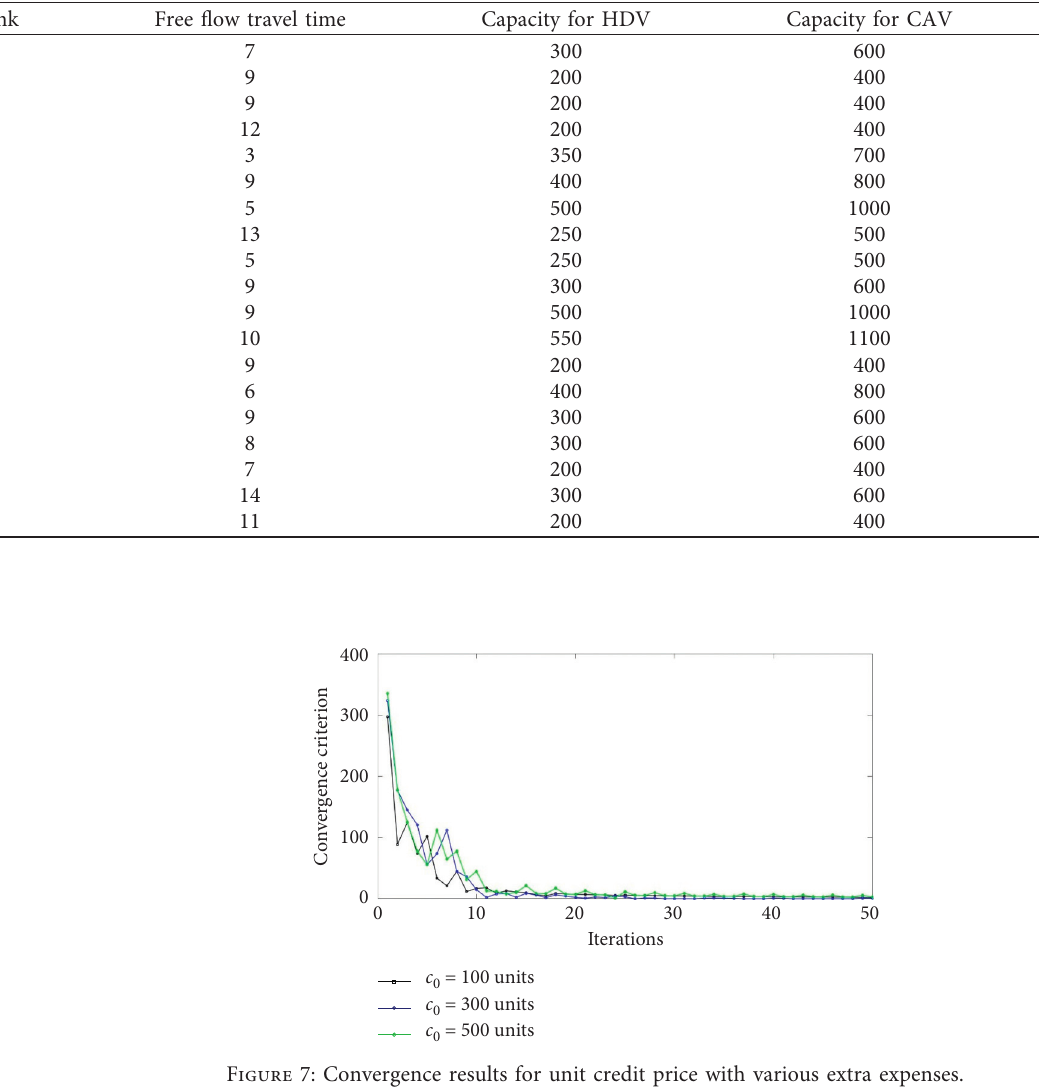
Figure 6: The Nguyen and Dupuis network. Table 2: Input data of Nguyen and Dupuis network.